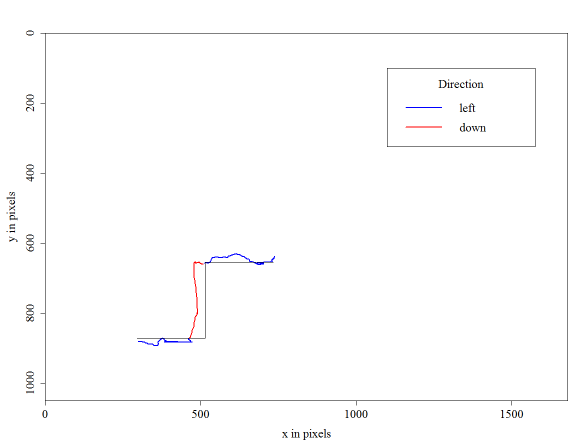
Figure 4. Resulting gaze track (colored line) of a pursued button movement (black line) on the display.